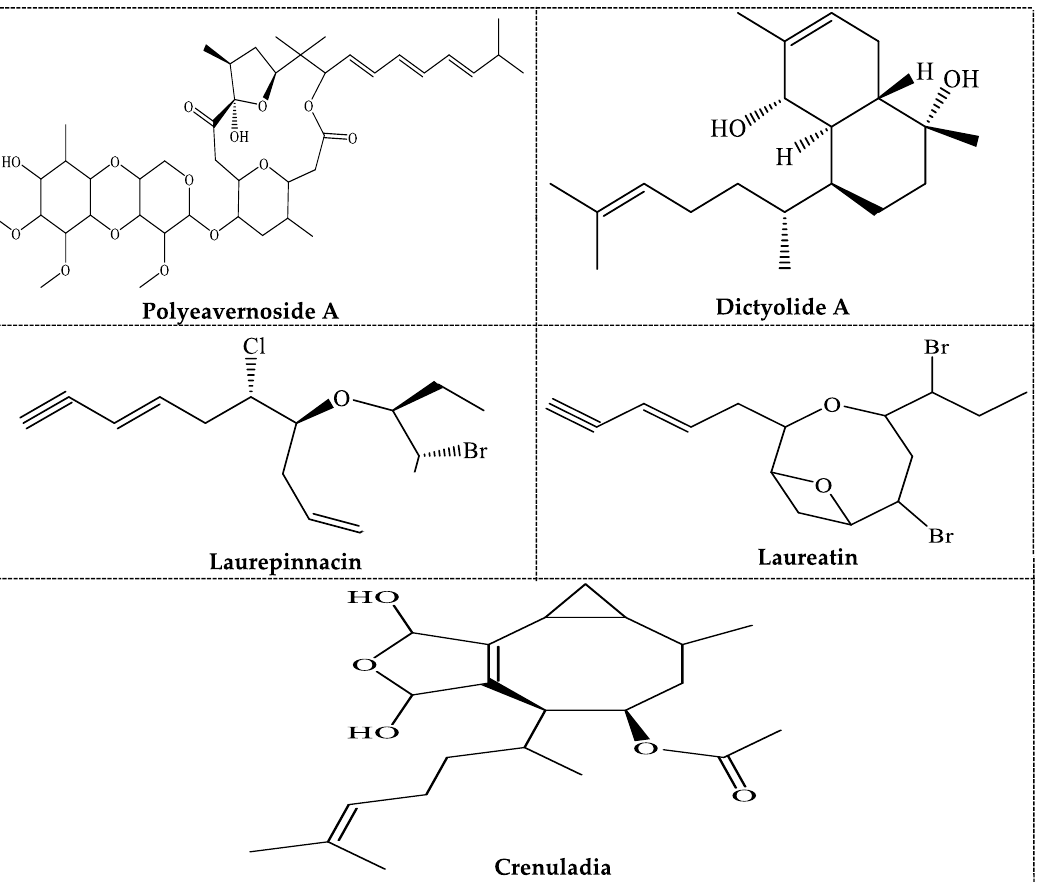
Figure 5. Some novel bioactive compounds from marine algae.